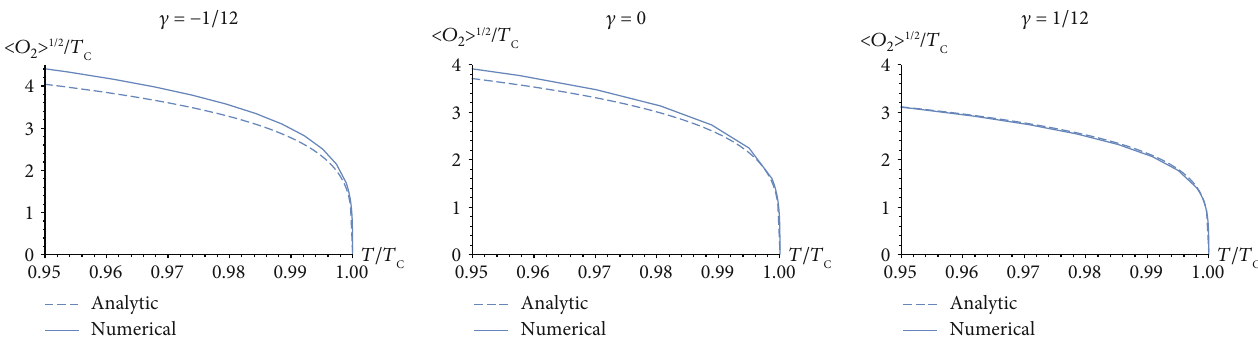
Figure 1: The condensation from 4-derivative theory for di ff erent γ obtained analytically and numerically,